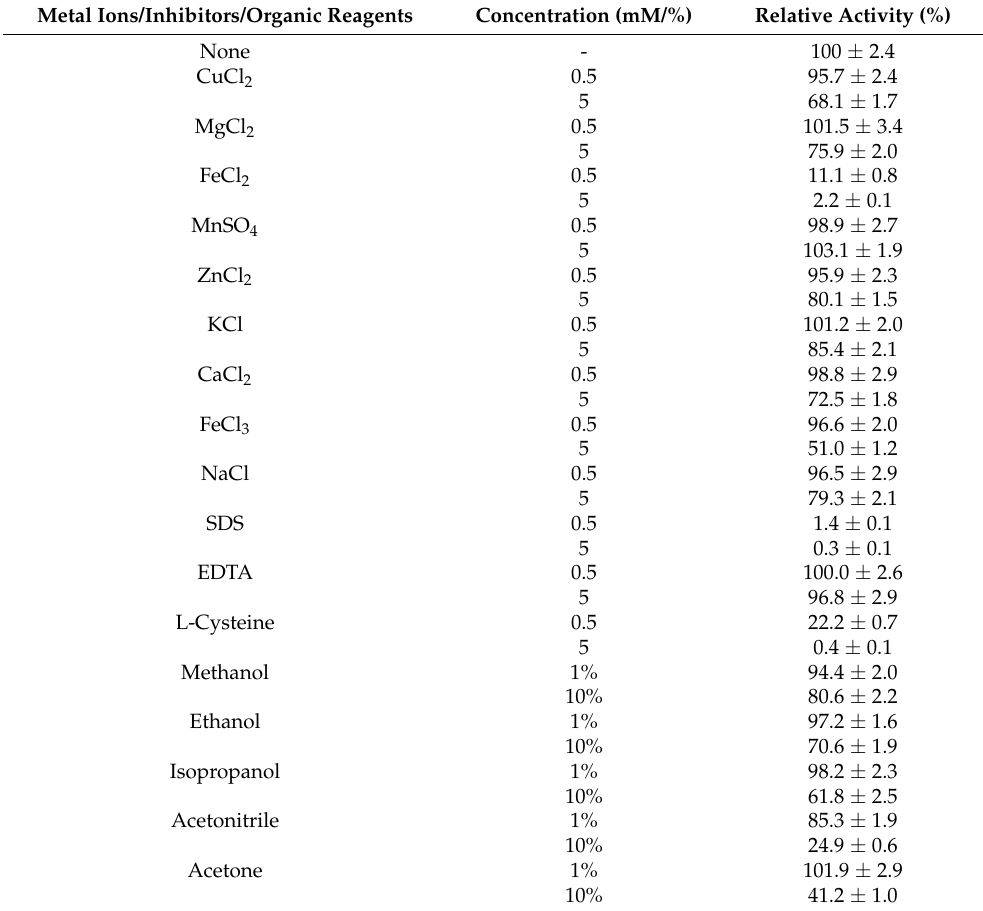
Table 1. Effects of metal ions, inhibitors, or organic reagents on the activity of rMCO. Values are means ± standard deviations of triplicate